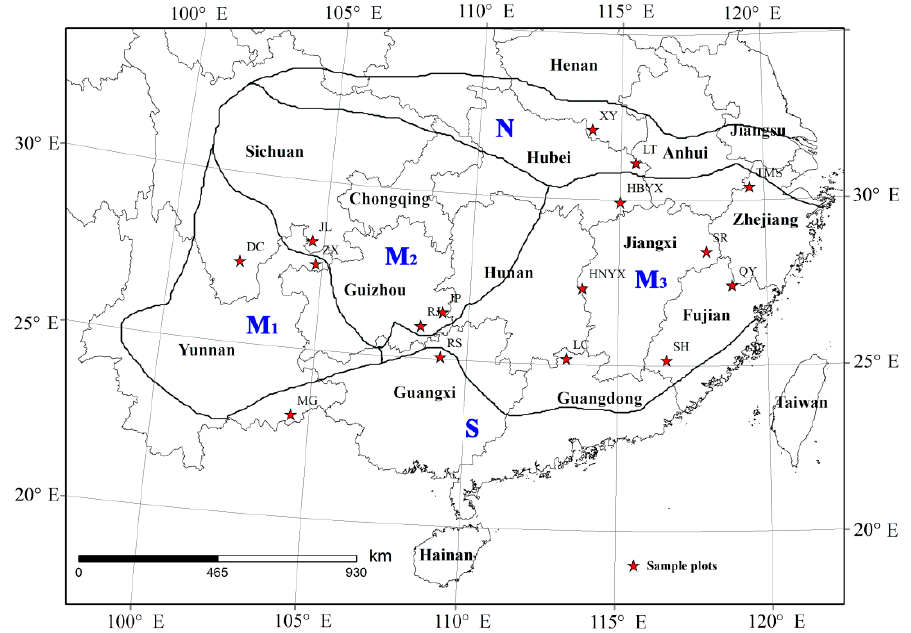
Figure 1. Natural distribution of Chinese fir and the location of sample plots. N, northern belt; M1, western middle belt; M2, central middle belt; M3, eastern middle belt; S, southern belt. MG, Yunnan Maguan; RS, Guangxi Rongshui; SH, Fujian Shanghang; LC, Guangdong Lechang; RJ, Guizhou Rongjiang; JP, Guizhou Jinping; HNYX, Hunan Youxian; DC, Sichuan Dechang; QY, Zhejiang Qingyuan; ZX, Yunnan Zhenxiong; JL, Sichuan Junlian; SR, Jiangxi Shangrao; HBYX, Hubei Yangxin; TMS, Zhejiang Tianmushan; LT, Hubei Luotian; XY, Henan Xinyang.